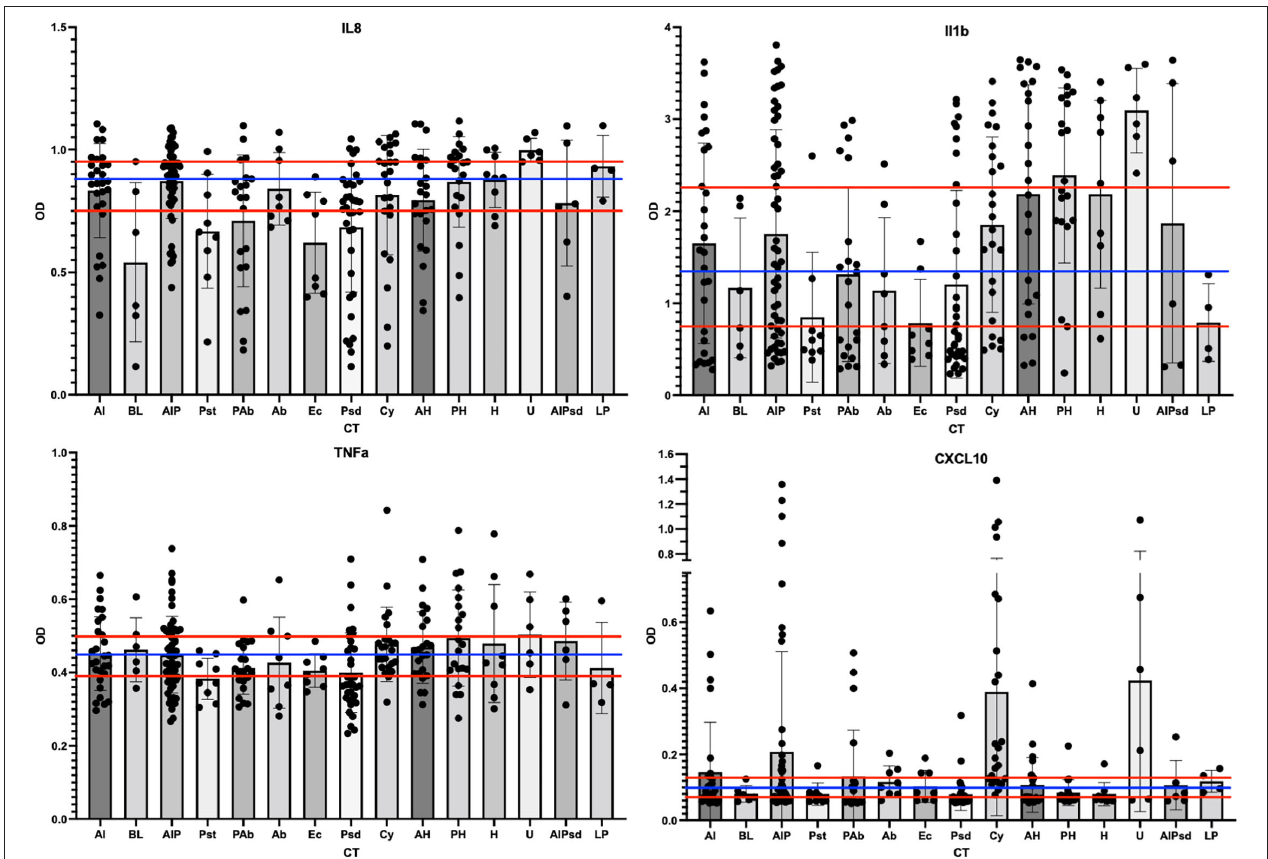
FIGURE 6 | Scatter plots of the cytokine levels for each of the CT. The ELISA results for each phase 3 sample were grouped by assigned CT and then scatter-plotted. The bar shows average levels of the group with standard deviations shown as bar and whiskers. The tertile divisions (high, medium, and low were determined from all samples in the study) are shown as horizontal red lines, and binary divisions (high and low) are shown by the blue horizontal line. IL-8 outcomes are shown in the top left panel, IL-1b top right, TNF-a lower left, and CXCL10 lower